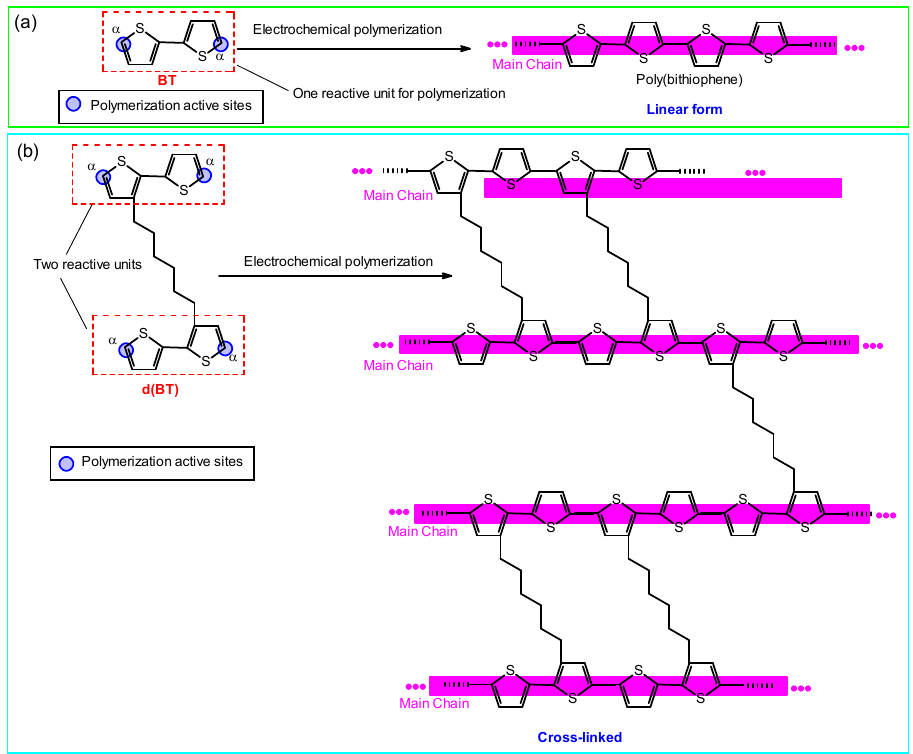
Figure 1. Plausible forms of linearly propagated BT (( a ), uncrosslinkable) and d(BT) (( b ),